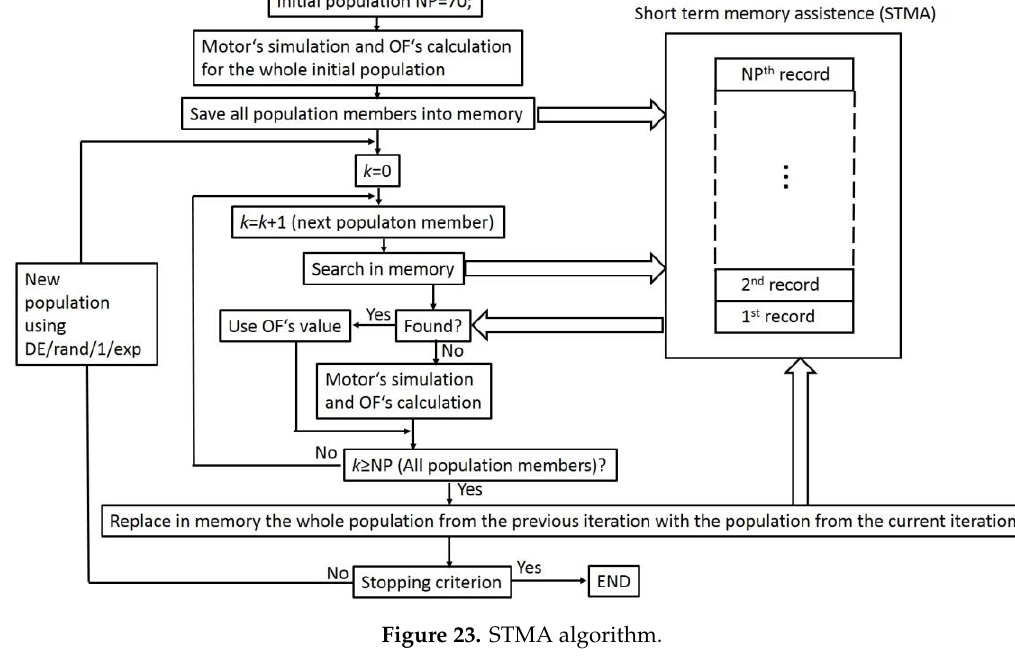
Figure 23. STMA algorithm.